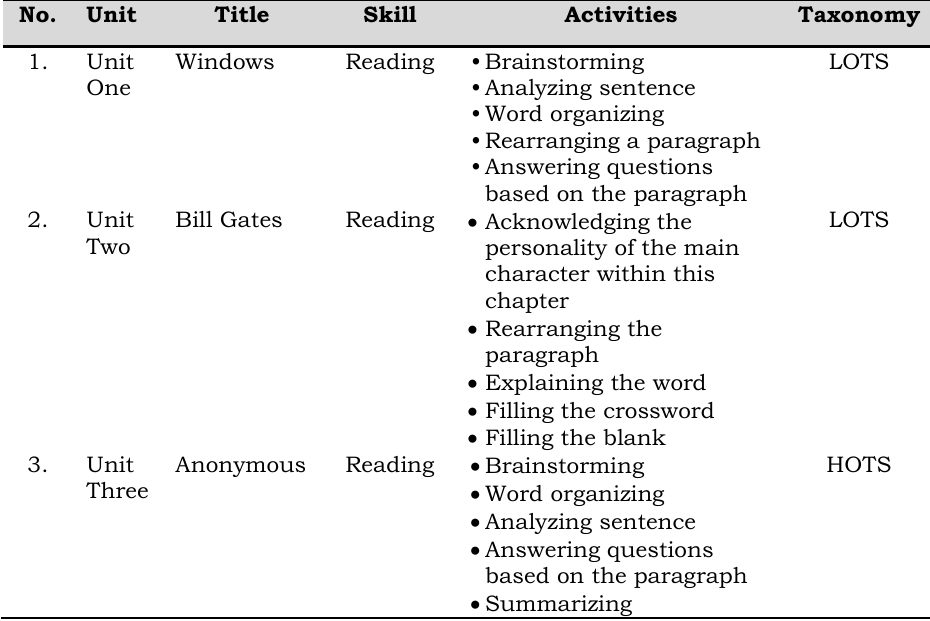
Table 3. The map of the developed course book